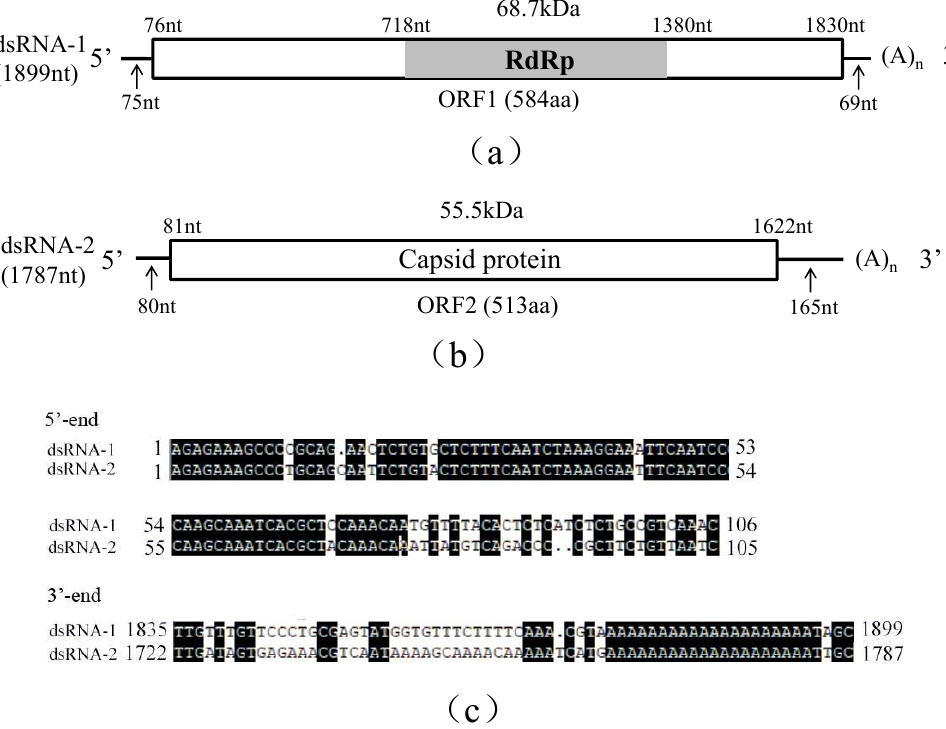
Figure 1. Schematic representation of the genomic organization of RsPV5 isolated from R. solani AG-1 IA strain C24, the causal agent of rice sheath blight. ( a ) Schematic representation of the genomic organization of dsRNA-1. The rectangle represents open reading frame (ORF 1) and the nucleotide positions of the start and end codons are listed above the box. The gray bar represents the conserved RNA-dependent RNA polymerase (RdRp), the predicted molecular masse and the nucleotide positions of the start and termination codons are listed above the bar. The arrows under the single lines represent the length of the non-coding sequence. ( b ) Schematic representation of the genomic organization of dsRNA-2. The rectangle represents the open reading frame (ORF 2) and its encoded protein, capsid protein (CP), the nucleotide positions of the start and end codons are listed above the box. The arrows under the single lines represent the length of the non-coding sequences. ( c ) Alignments of 5 (cid:48) - and 3 (cid:48) -untranslated regions (UTRs) of RsPV5 dsRNA-1 and dsRNA-2. The letters with black shading represent conserved sequences at both